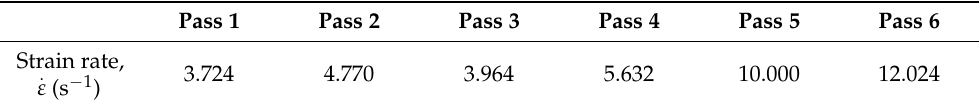
Table 3. Average effective strain rate obtained from the FEM simulation. Pass 1 Pass 2 Pass 3